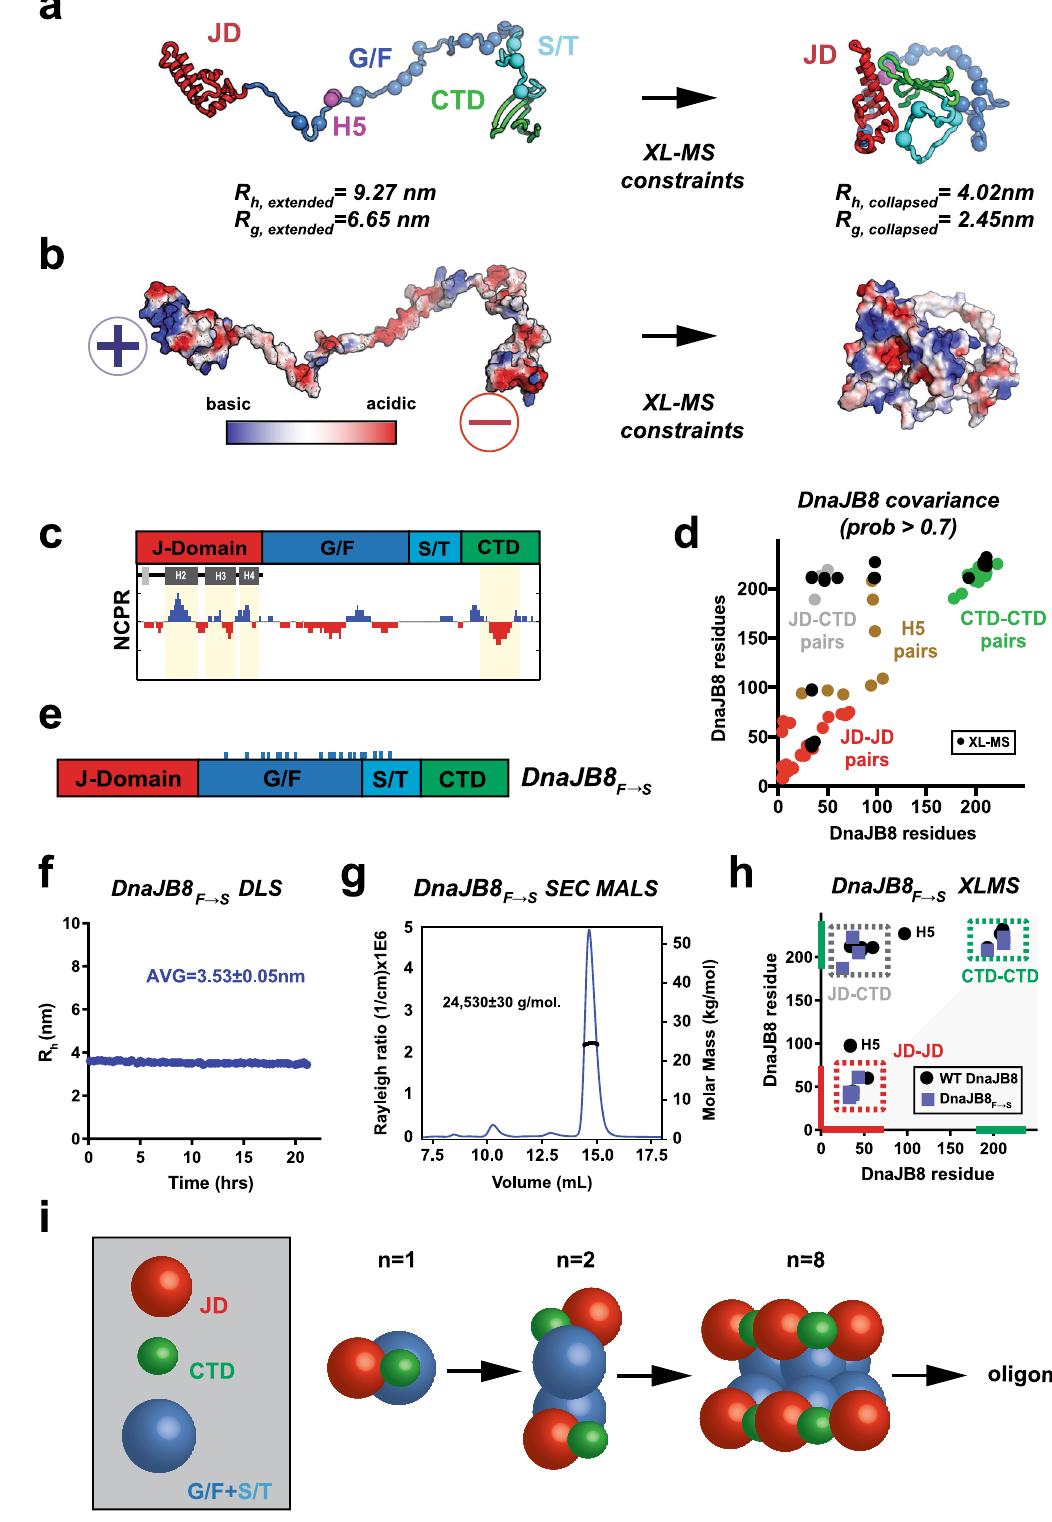
(Fig. 1e). The DnaJB8 F → S mutant showed a radius of 3.53